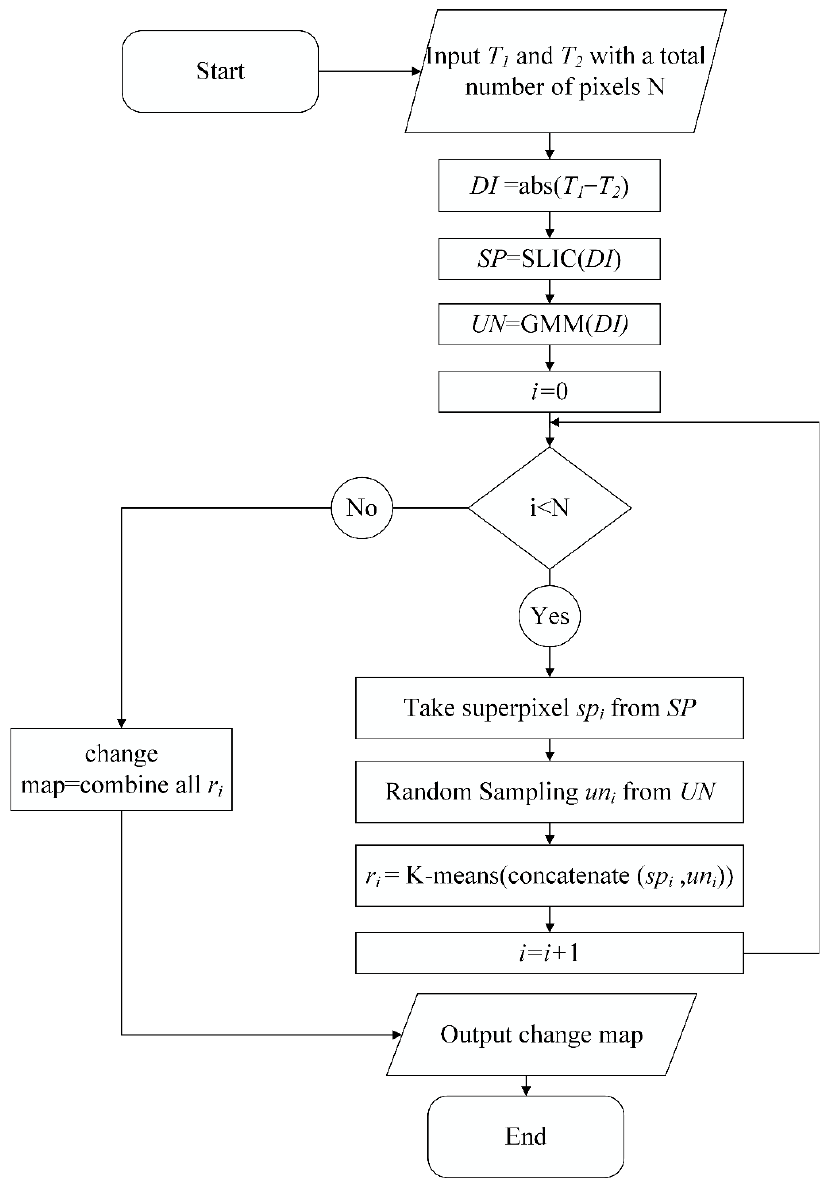
Figure 4. The flow chart of the proposed SSCF algorithm.